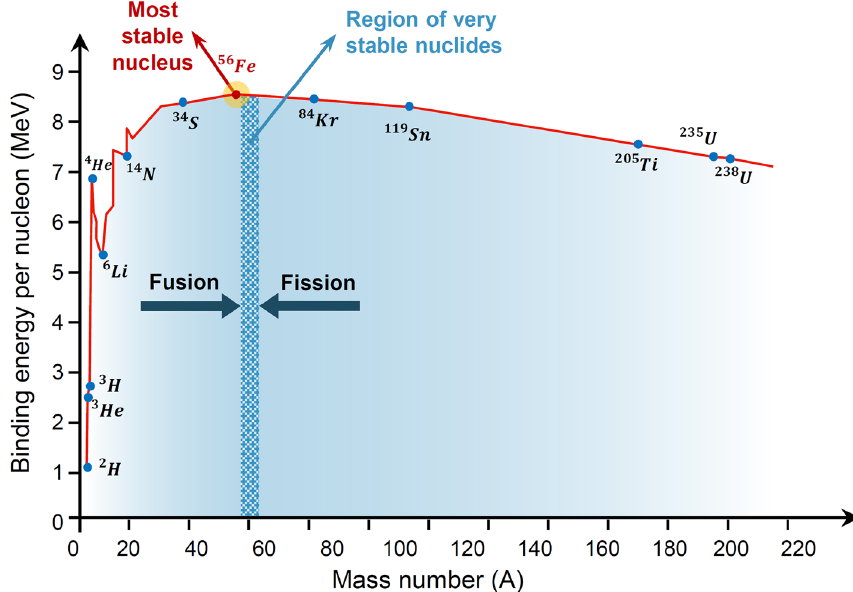
Figure 1. Experimental binding energy B Avg ( A , Z ) with respect to mass number A 49 .